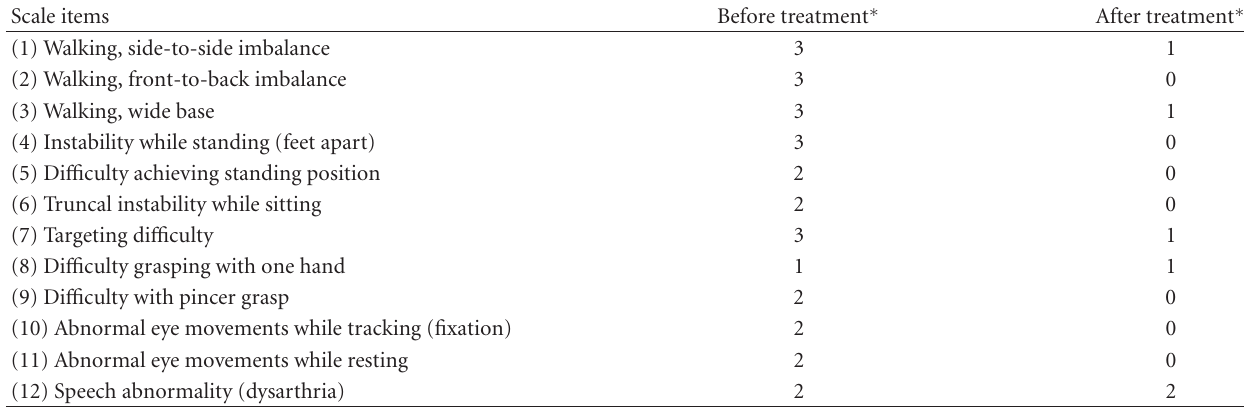
Table 1: E ff ects of rituximab on motor performance: a comparison of OMS evaluation scale scores before and after treatment. Scale items Before treatment